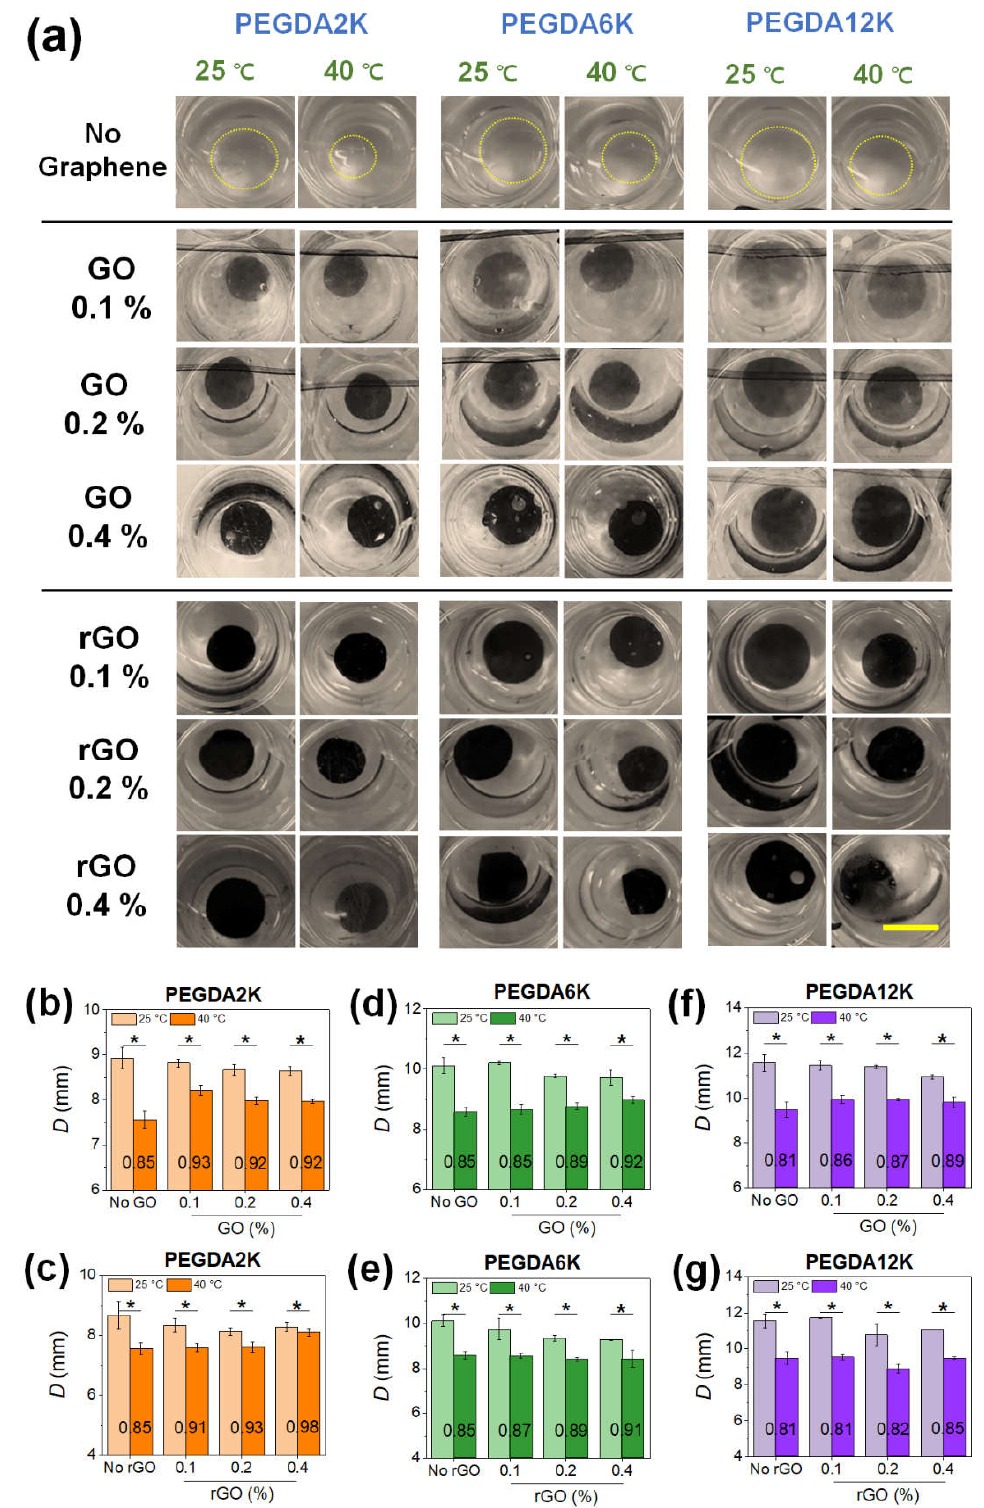
Figure 3. ( a ) Photographs of GO- or rGO-laden PEG-PNIPAm hydrogel disks undergoing thermoresponsive deswelling from 25 °C to 40 °C (scale bar: 1 cm). The concentration of PEGDA was 10%. ( b – g ) The diameters ( D ) of the hydrogel disks at 25 °C ( D BT ) and at 40 °C ( D AT ) shown in ( a ) were quantified: ( b , c ) PEGDA2K, ( d , e ) PEGDA6K, and ( f , g ) PEGDA12K (* p < 0.05 compared between 25 °C and 40 °C, n = 10). D AT / D BT value at each condition is denoted.